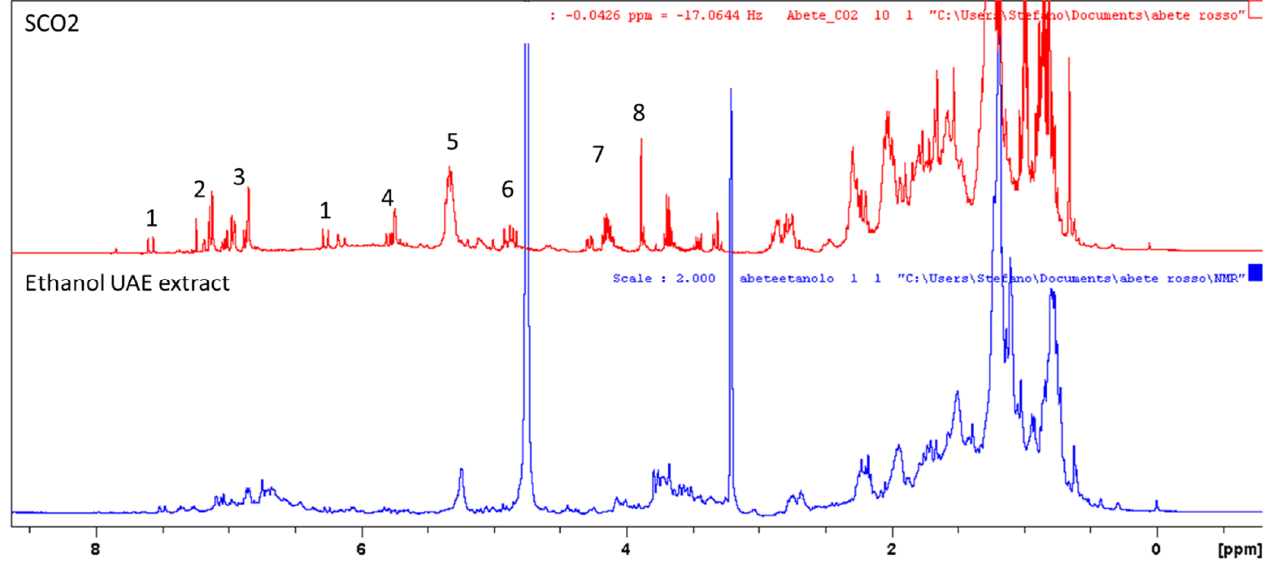
Figure 2. Main signals observed in the 1 H-NMR spectrum of SCO 2 and extract obtained from barks after UAE in ethanol (RU_e). Table 2. Tentatively assignment of NMR signals ascribable to hydroxycinnamic esters, phenolics, abietanes Signal Number in